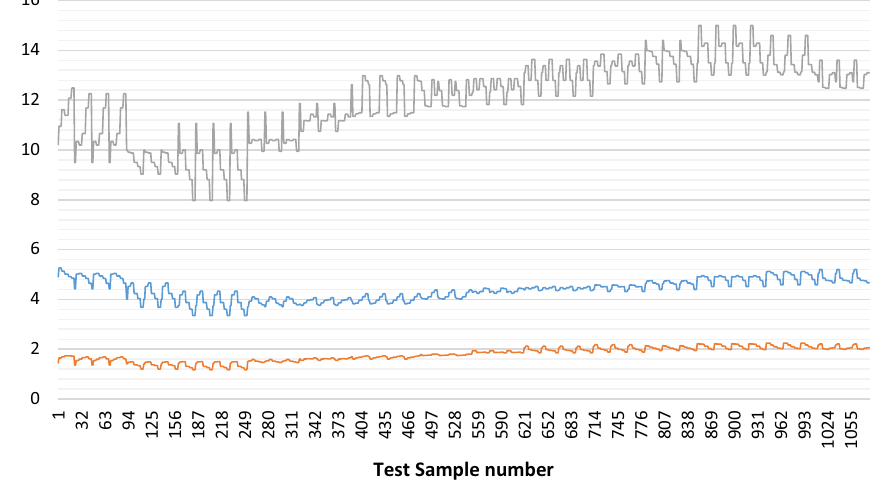
Fig. 11 Statistics evolution for all wind speed data